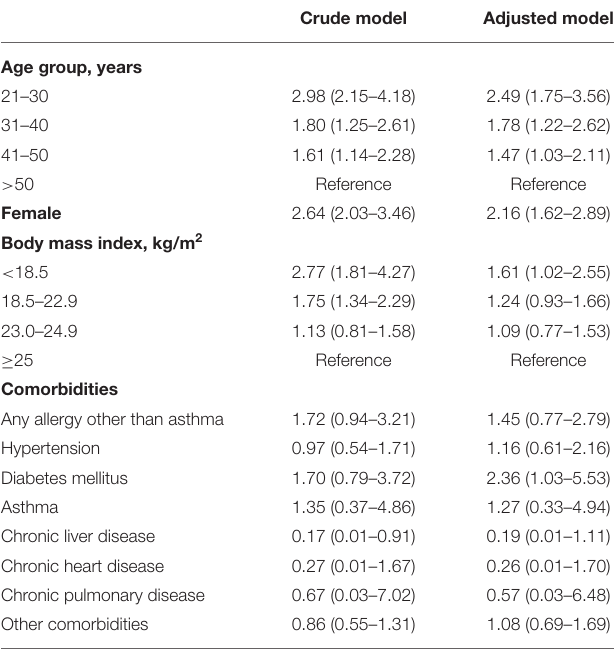
TABLE 2 | Factors associated with overall grade 3 to grade 4 adverse